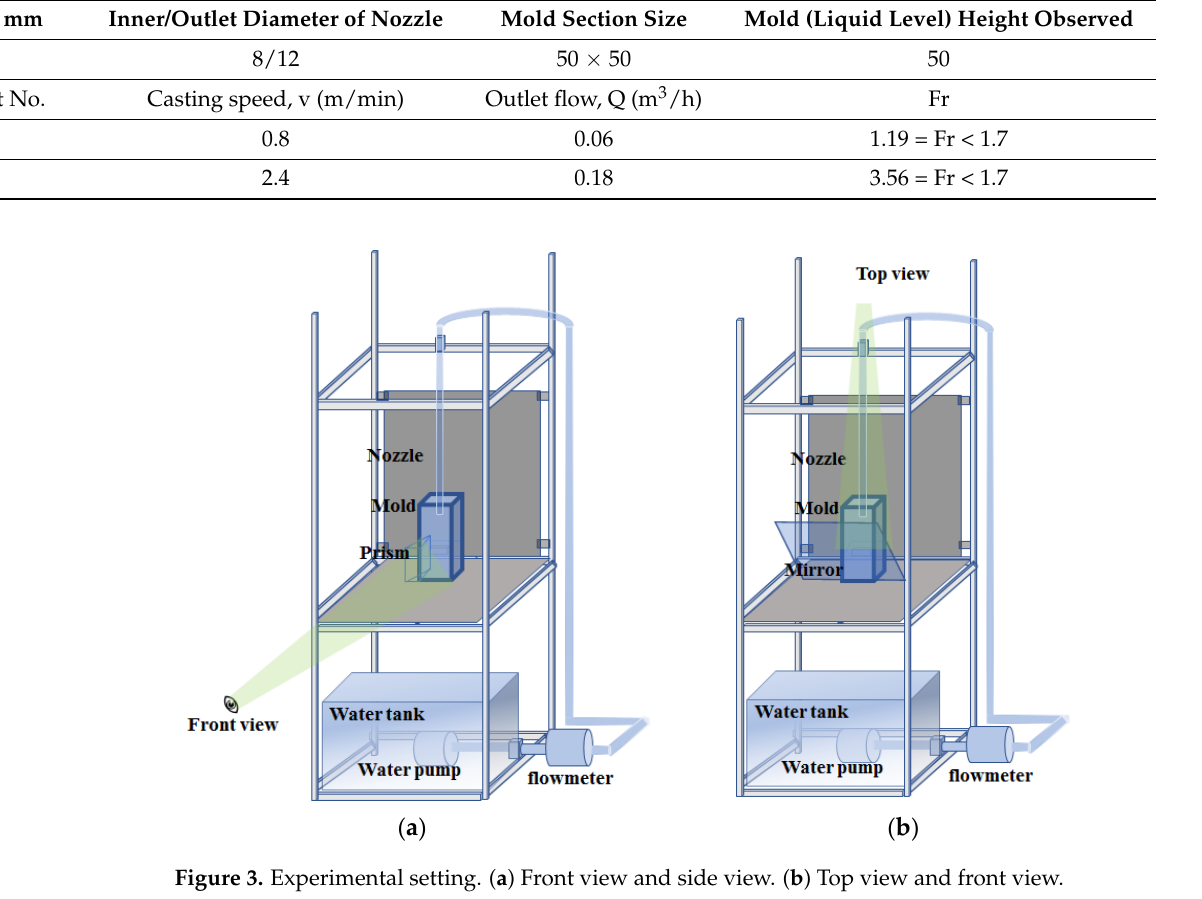
Table 1. Geometric parameters of the mold and experimental condition.